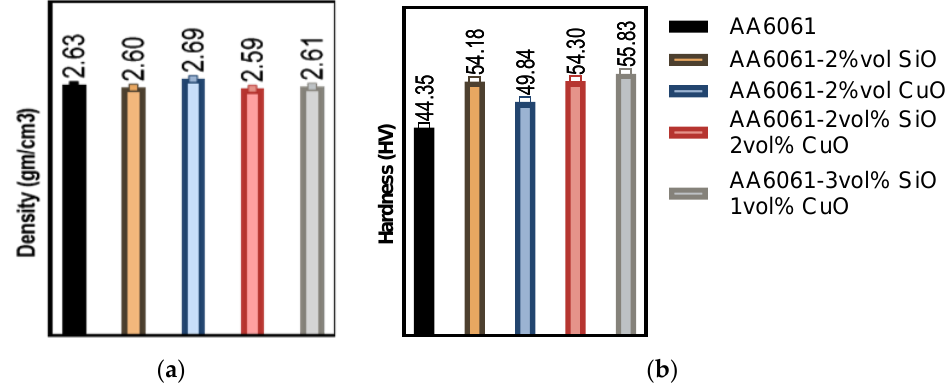
Figure 2. UTS of various composite samples.